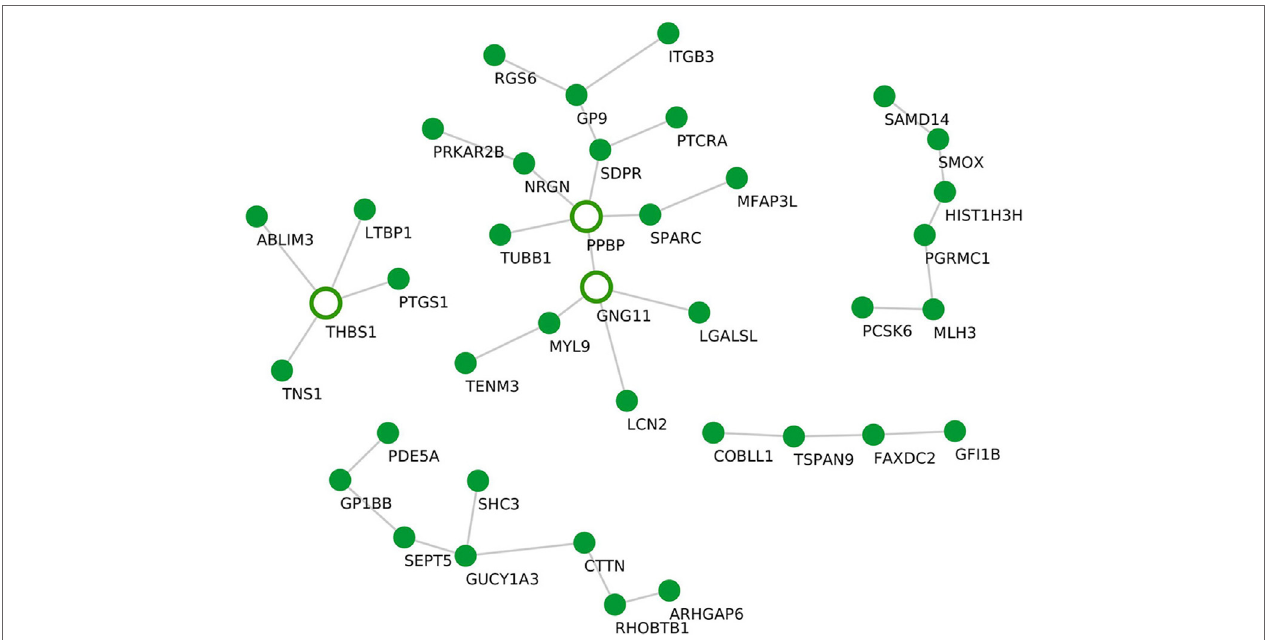
FigUre 4 | Gene–gene interaction network for the “salmon” module. De novo network generated by C3NET algorithm for the “salmon” module. The figure shows statistically significant ( α < 0.05) edges predicted by the algorithm. Fully colored nodes represent the “salmon” module-associated genes. Empty nodes represent the regulatory genes (degree ≥